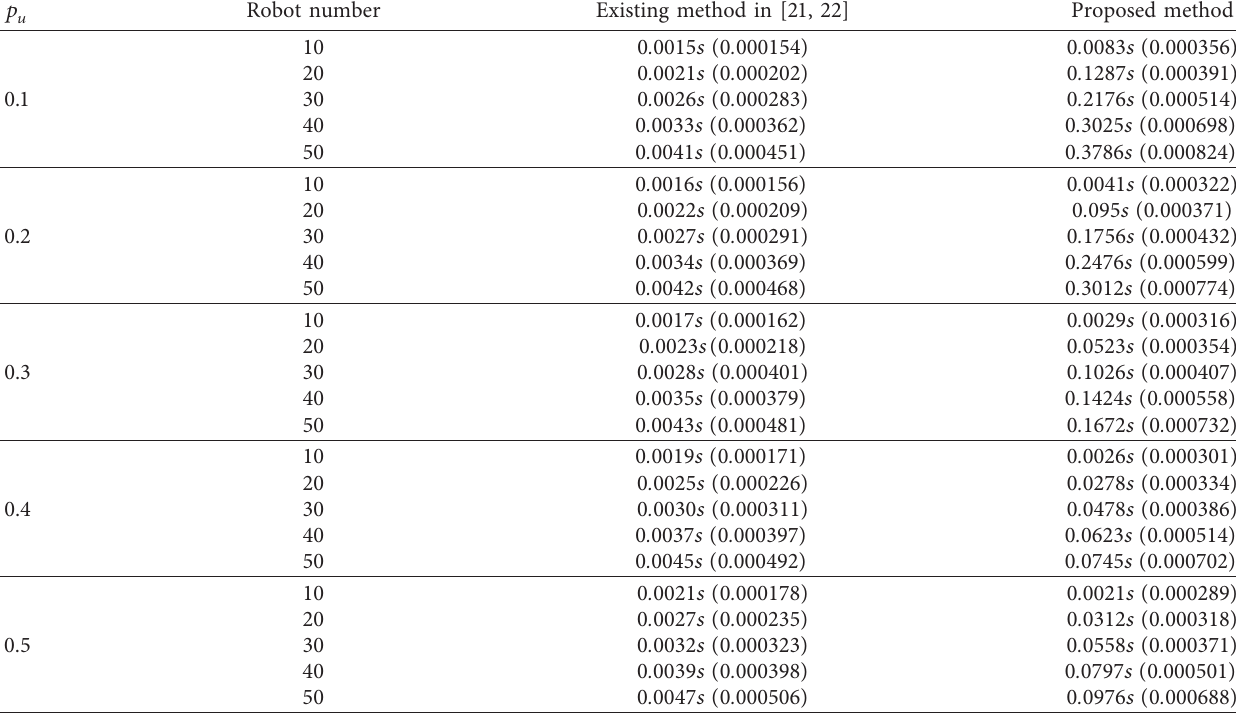
Table 4: Simulation results in a warehouse environment of 50 × 34 4-neighbor grids: computation time (standard deviation). p